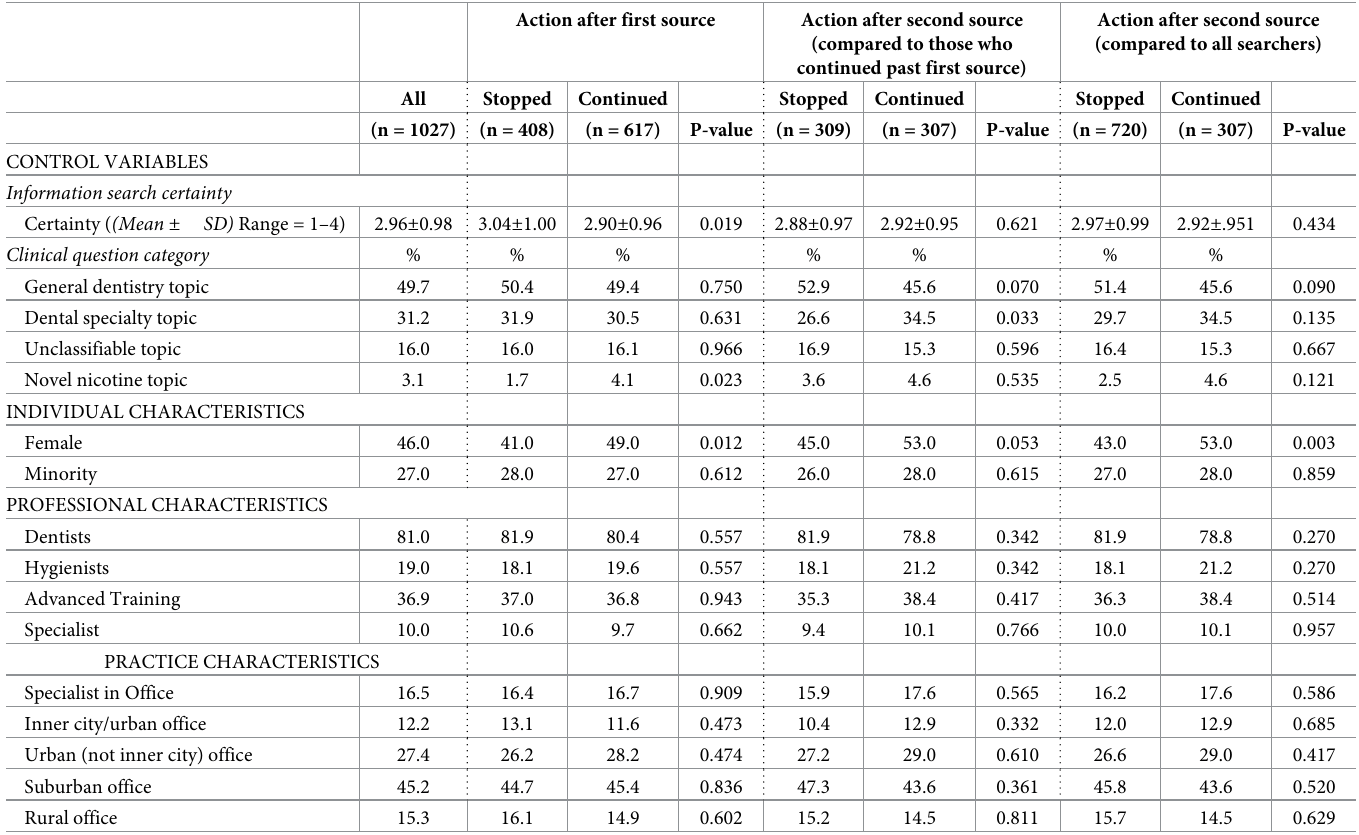
Table 4. Comparison of individuals who continued searching to those who